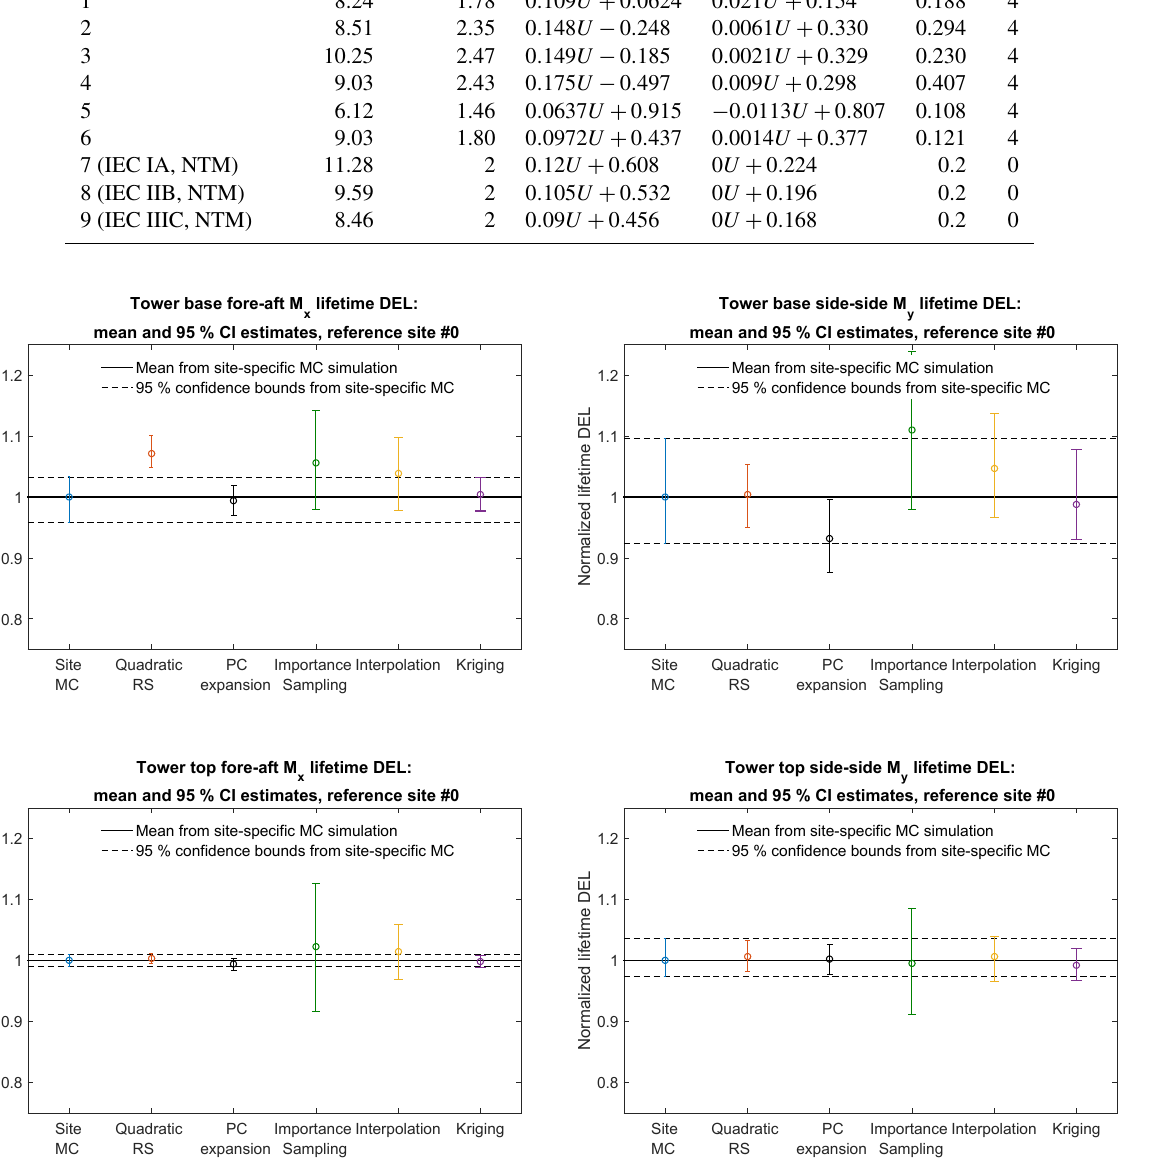
Figure 8. Comparison of predictions of the lifetime damage-equivalent loads (DELs) for six different estimation approaches. All values are normalized with respect to the mean estimate from a site-specific Monte Carlo